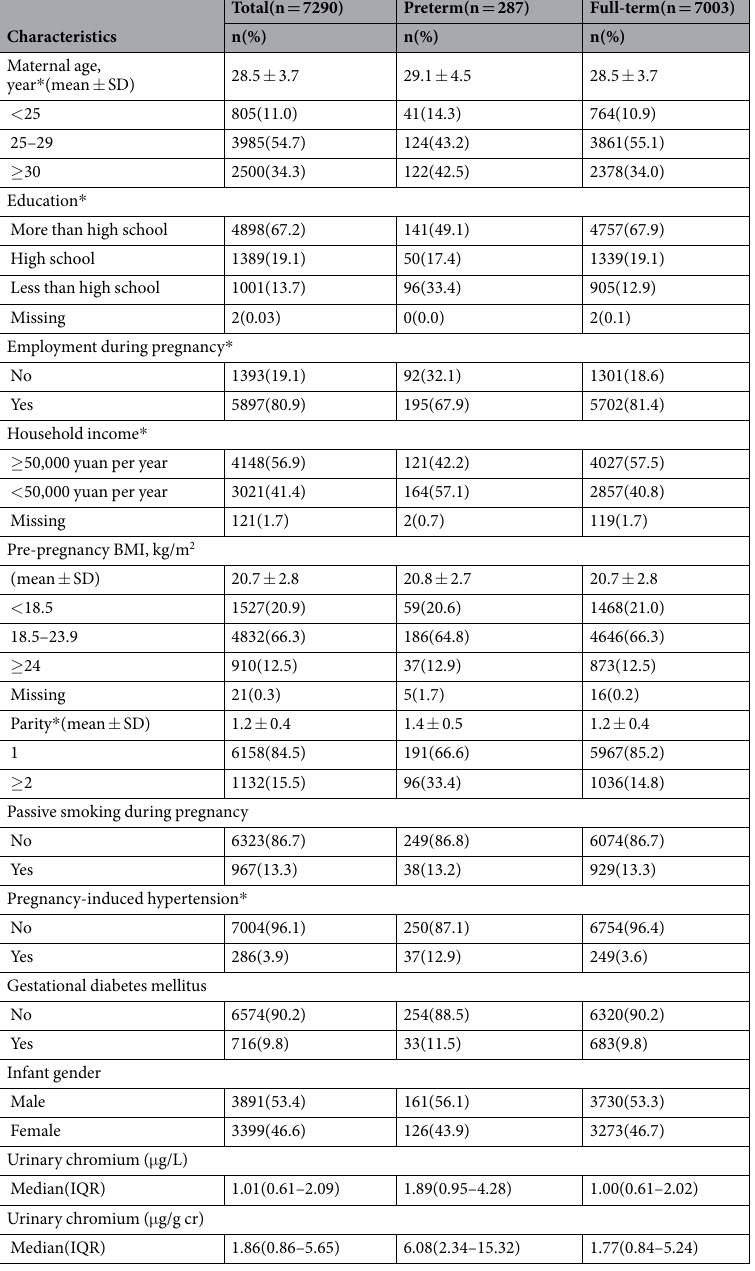
Table 1. Distribution of Selected Characteristics of the Study Population (n = 7290). * p < 0.01, SD = Standard deviation, GM = Geometric